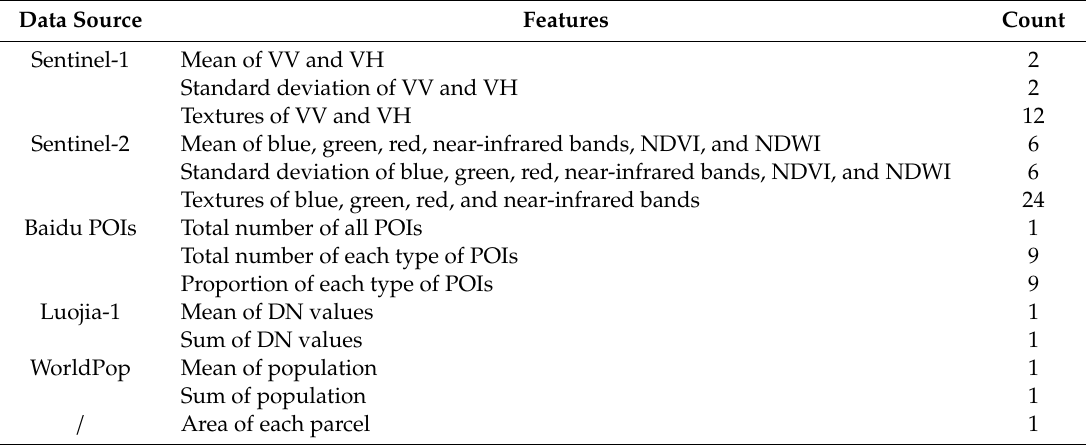
Table 1. Summary of